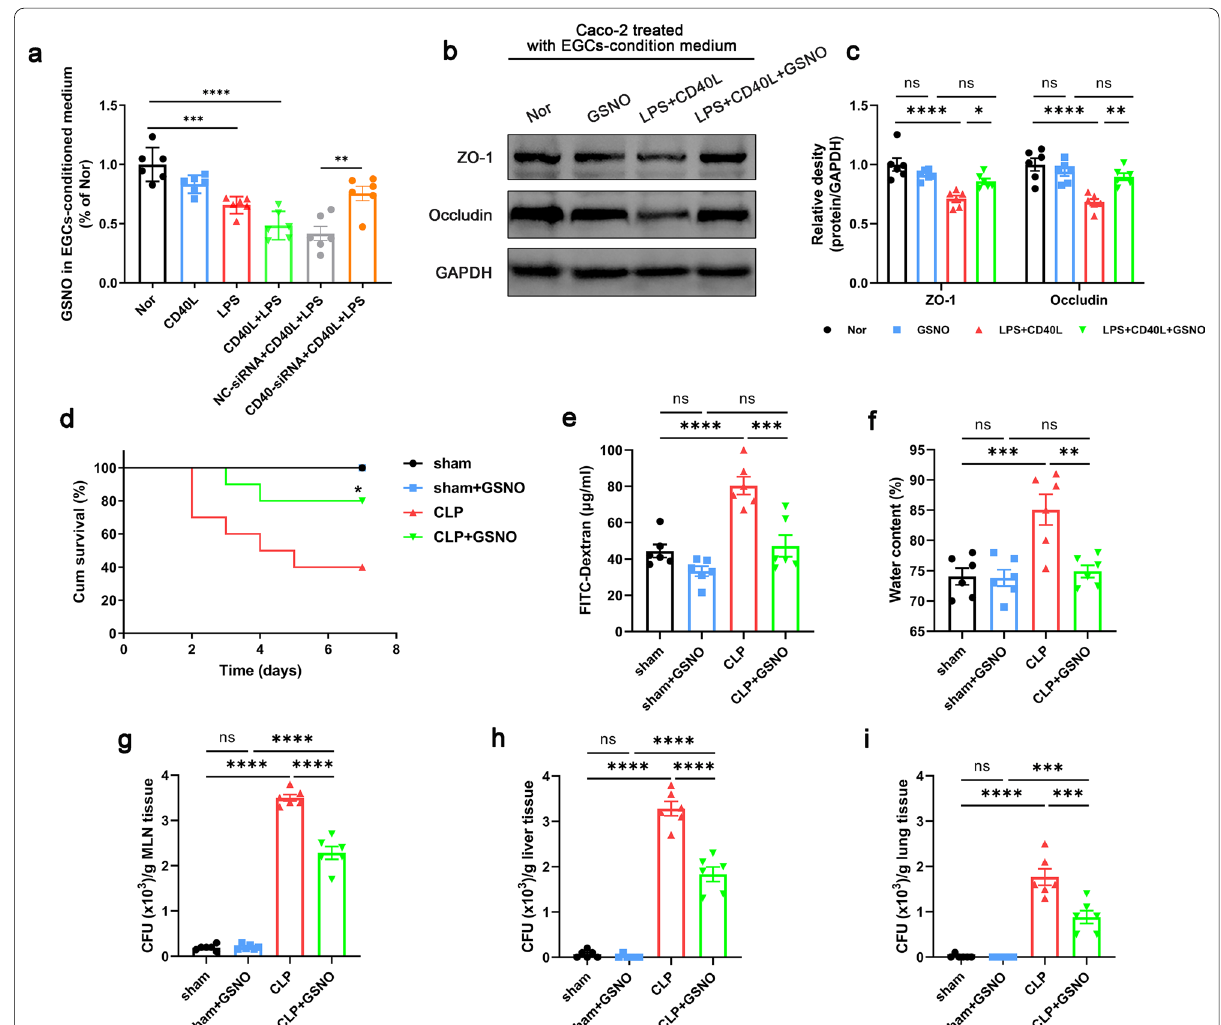
Fig. 6 Effect of GSNO pretreatment on intestinal epithelial barrier. In vitro, EGCs-conditioned medium was collected to measure the GSNO level ( a ) (n 6). The levels of ZO-1 and occludin expression in Caco-2 cells were evaluated by western blot after the stimulation of EGCs-conditioned = medium with or without GSNO 50 µM) supplementation ( b , c ) (n 6). In vivo, GSNO was administrated intraperitoneally at 10 mg/kg/day for 7 days = before CLP. 24 h after CLP, mice were sacrificed, and tissue samples were collected. d The survival percentage of the mice was investigated within 7 days after CLP by survival curves (n 10). Intestinal barrier permeability was indicated by serum FITC-Dextran levels ( e ) (n 6), water content = = ( f ) of gut (n 6), and colony-forming units (CFUs) ( g – i ) from mesenteric lymph node (MLN), liver and lung (n 6). The data are presented as the = = mean SEM, * P < 0.05, ** P < 0.01, *** P < 0.001, **** P < ±